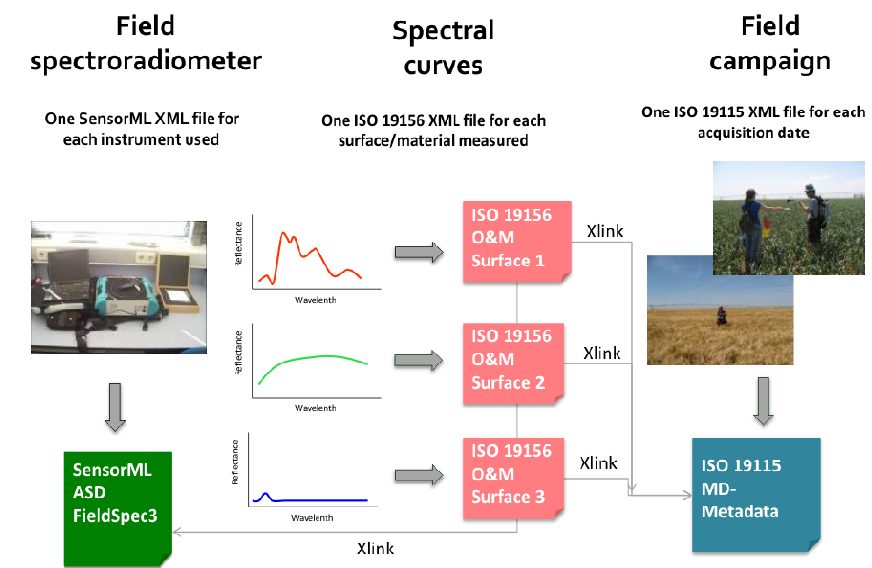
Figure 2. Metadata structure for field spectroscopy based on ISO 19156 (O&M), ISO 19115 (MD) and Sensor Model Language